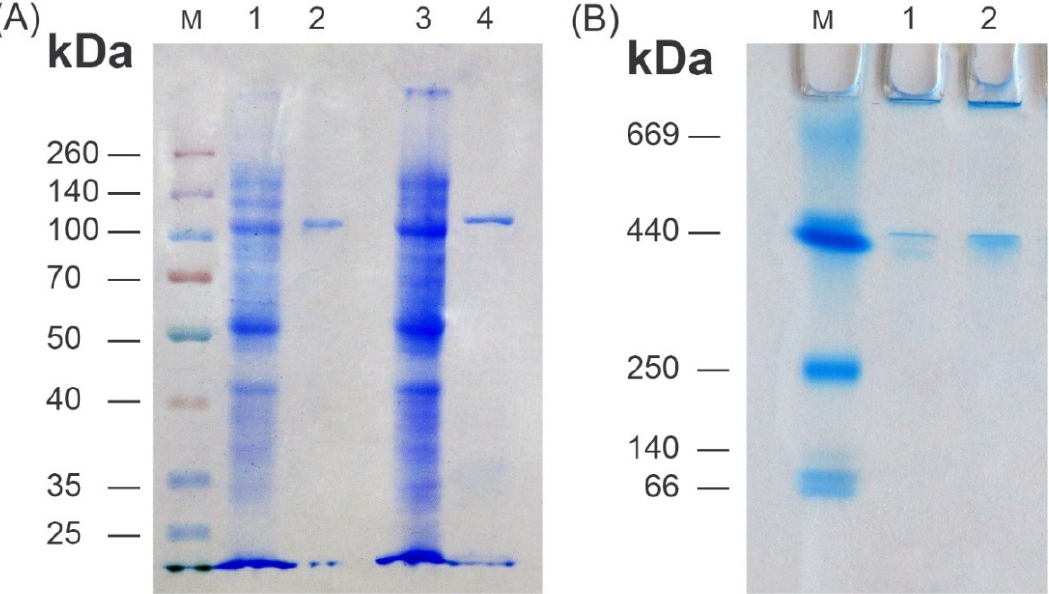
Figure 6. SDS-PAGE ( A ) and non-denaturing 4–20% gradient PAGE ( B ). ( A ) M—molecular weight marker (Spectra™ Multicolor Broad Range Protein Ladder, Thermo Scientific™, #26634); 1—crude extract of recombinant D2HGDH Pa ; 2—purified D2HGDH Pa ; 3—crude extract of recombinant